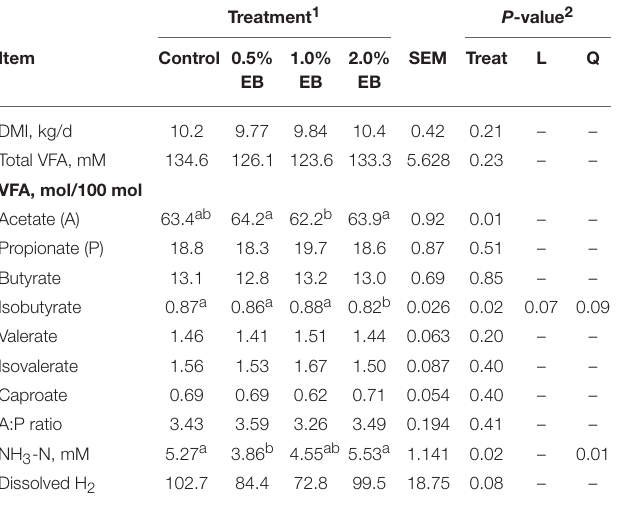
TABLE 3 | Dry matter intake and ruminal fermentation products of beef heifers fed a barley silage-based diet containing increasing addition of enhanced biochar (EB; n = 8 per treatment).